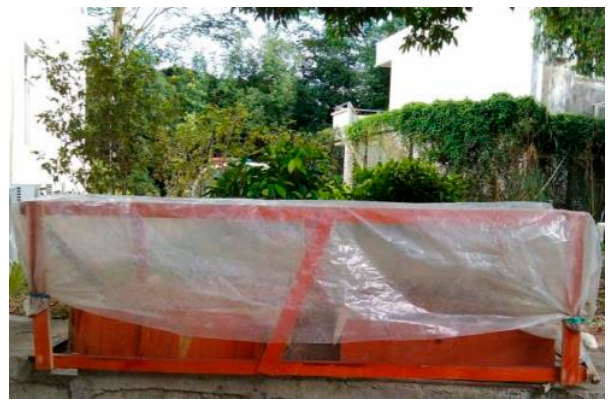
Figure 7. The vegetation-pervious concrete samples in a shed.